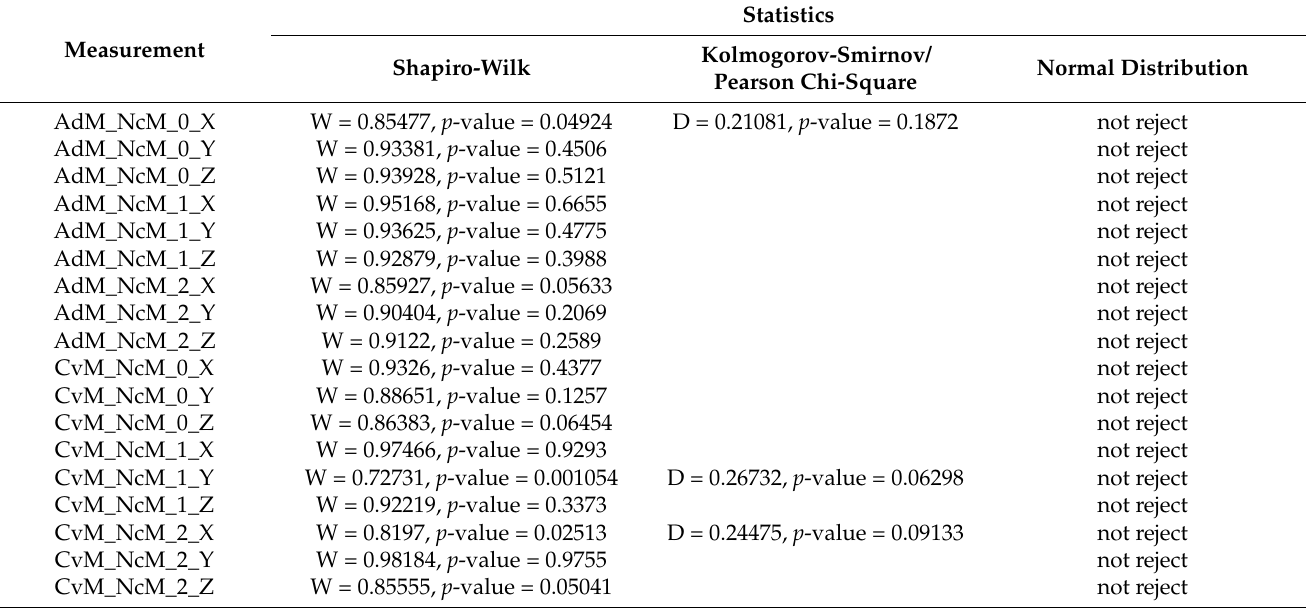
Table 6. NcM normality